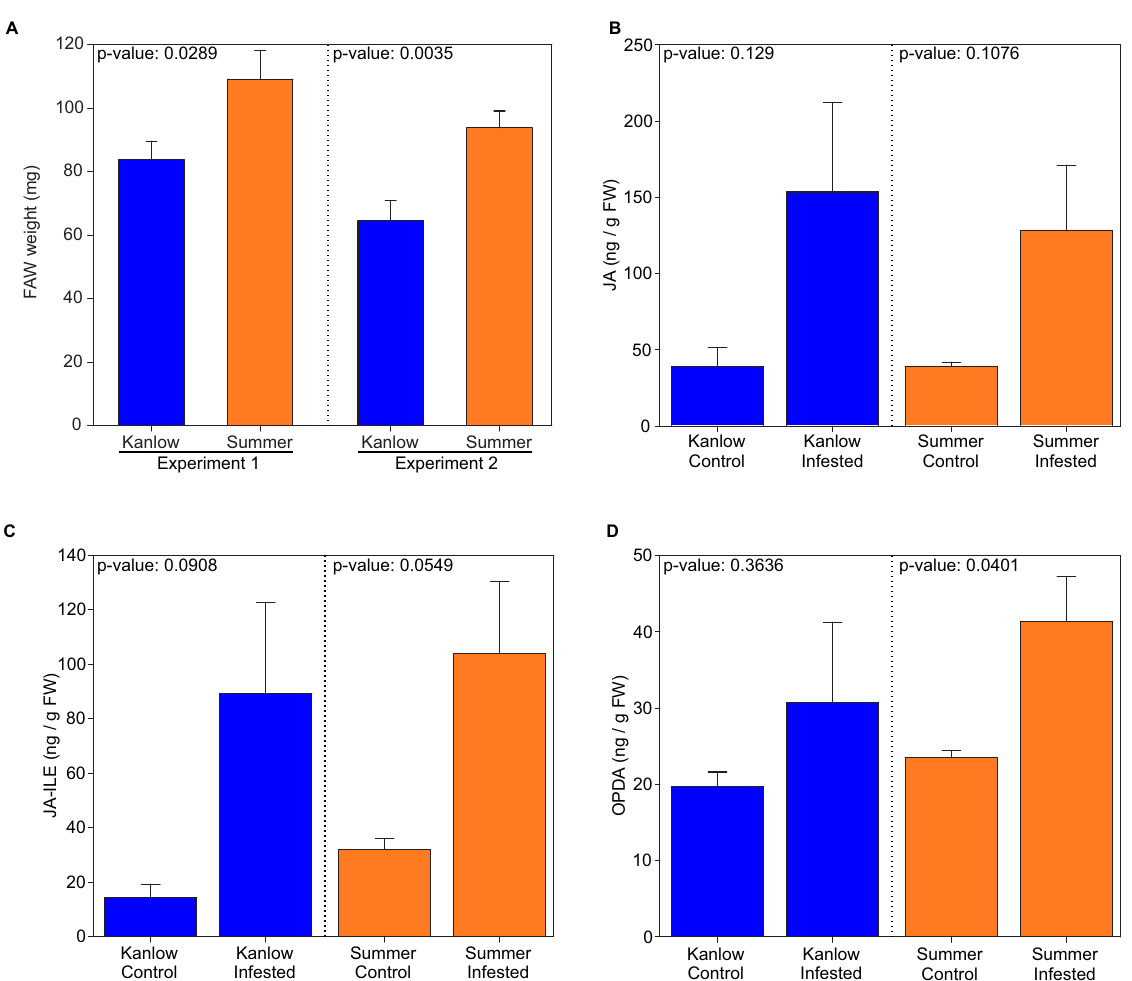
Fig 1. Bioassay and Phytohormones. (A) FAW weight 10 dpi on Kanlow (blue) or Summer (orange) seedlings. (B) Jasmonic acid (JA) quantification in Kanlow (blue) and Summer (orange) seedlings in uninfested control and FAW infested seedlings after 10 dpi. (C) JA-Ile quantification in Kanlow (blue) and Summer (orange) seedlings in uninfested control and FAW infested seedlings after 10 dpi. (D) OPDA quantification in Kanlow (blue) and Summer (orange) seedlings in uninfested control and FAW infested seedlings after 10 dpi. Different letters above the bars indicate values that are significantly different from each other ( P < 0.05; Tukey’s test). Error bars represent